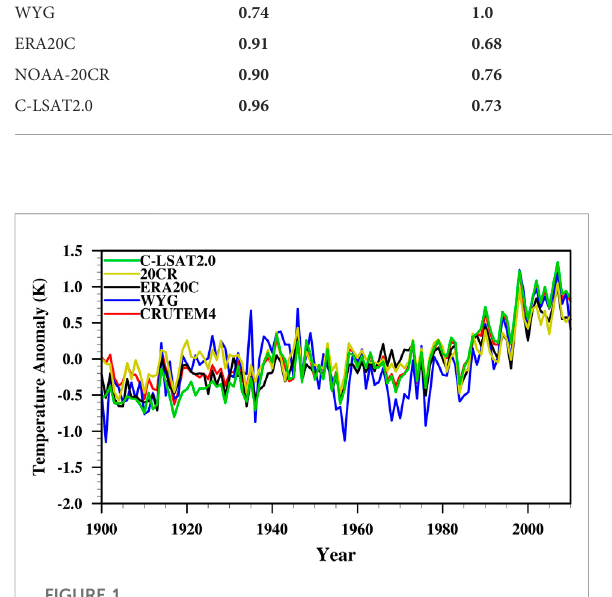
FIGURE 1 Temporal evolutions of the annual mean SAT anomalies (units: K; relative to 1961 – 1990 mean) averaged in China during 1900 – 2015 from NOAA_20CR (yellow), ERA20C (black), WYG (blue), CRUTEM4 (red), C-LSAT2.0 (green).